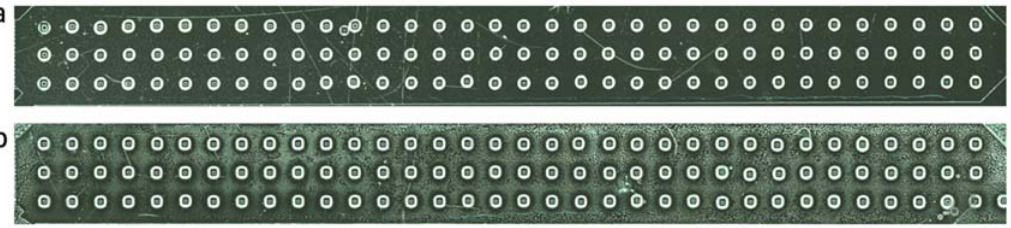
Figure 4. Con A and yeast cells dispensing into the microwells of the microfluidic ship (pulse duration of 15 µ s, voltage of 75 V and frequency of 50 Hz): ( a ) 60 droplets of Con A were printed, ( b ) 40 droplets were printed from the yeast solution (OD 600 of